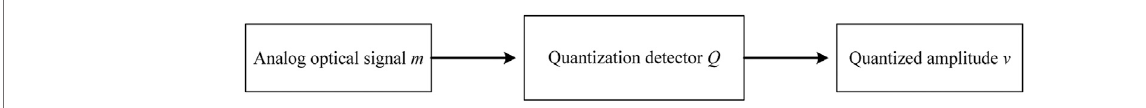
FIGURE 2 | Block diagram of memoryless quantizer.